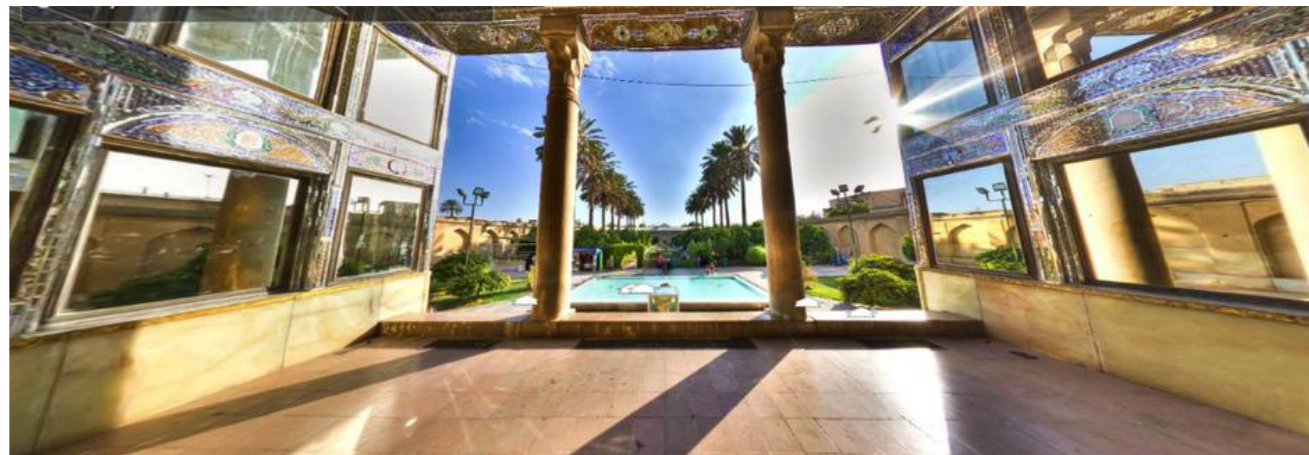
Figure 19. Narenjestan Ghavam house in Shiraz with a yard as a miniature garden, photo by: Mohammad Reza Domiri